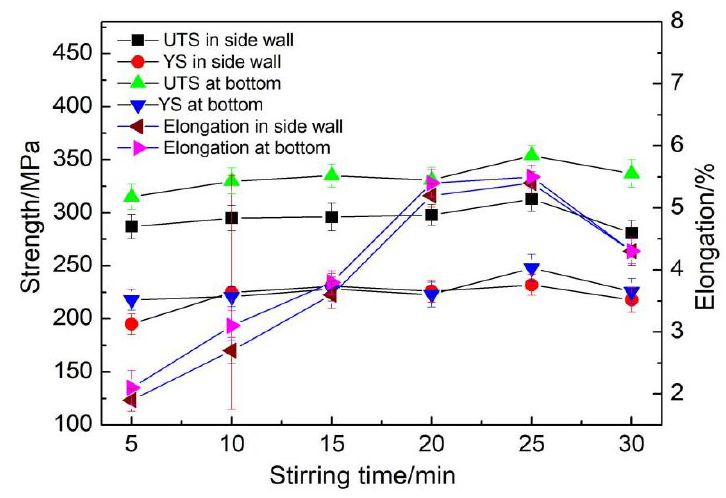
Figure 9. Influence of different stirring time on mechanical properties of rheoformed 2024 aluminum matrix composite component reinforced by 5 vol % Al 2 O 3 nanoparticles at 620 °C.